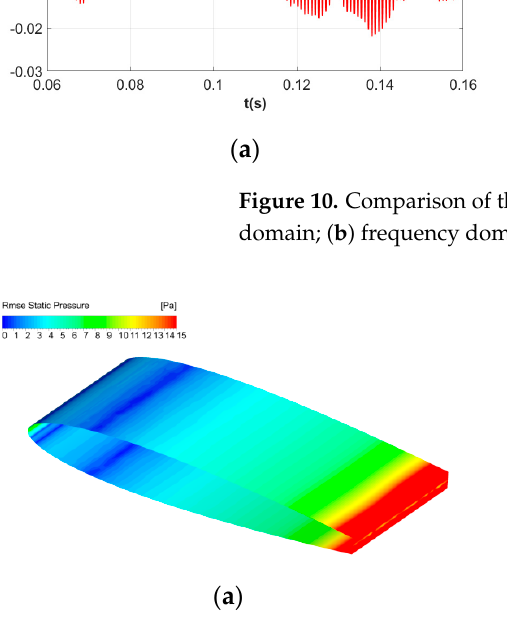
Figure 10. Comparison of the lift coe ffi cient between the baseline airfoil and A10W10 airfoil: ( a ) time domain; ( b ) frequency domain.